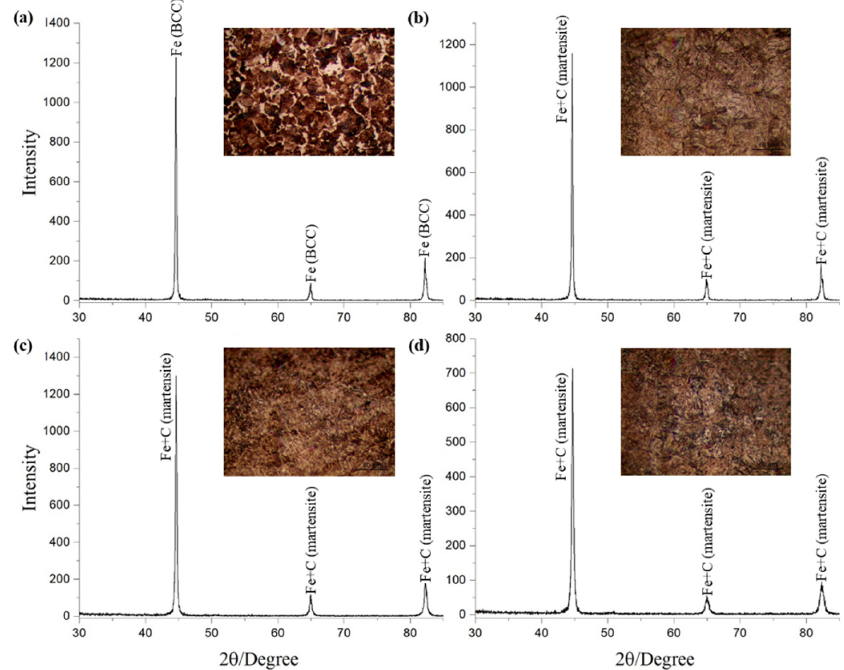
Figure 3. Diffractograms of 40 Kh steel: ( a ) initial, ( b ) No.1, ( c ) No.2 and ( d ) No.3. By periodically switching on a high voltage electrical potential of 320 V and a low voltage (pause) of 50, 250 V, the heating rate was increased and decreased, which then